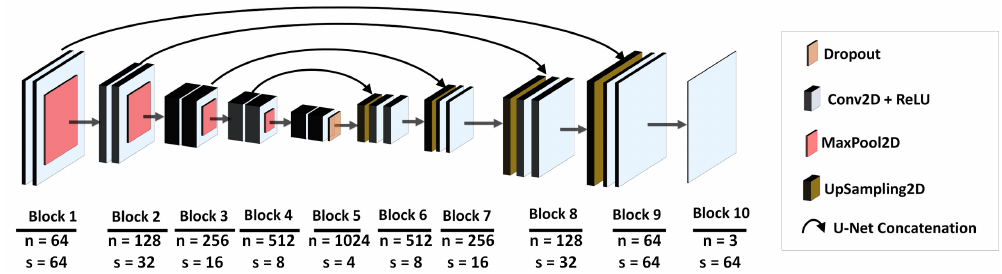
Figure 6. The architecture of the U-Net model [34], where n denotes number of filters and s is features size.